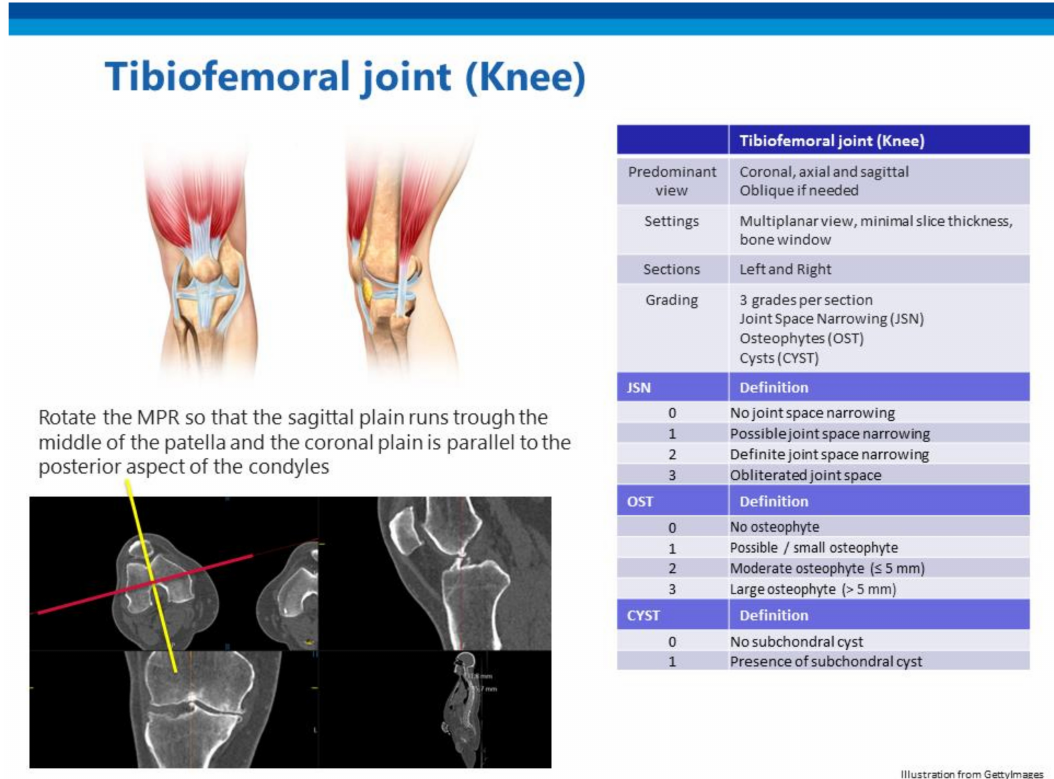
Figure 1. An example from the atlas showing the overview for scoring tibiofemoral osteoarthritis.